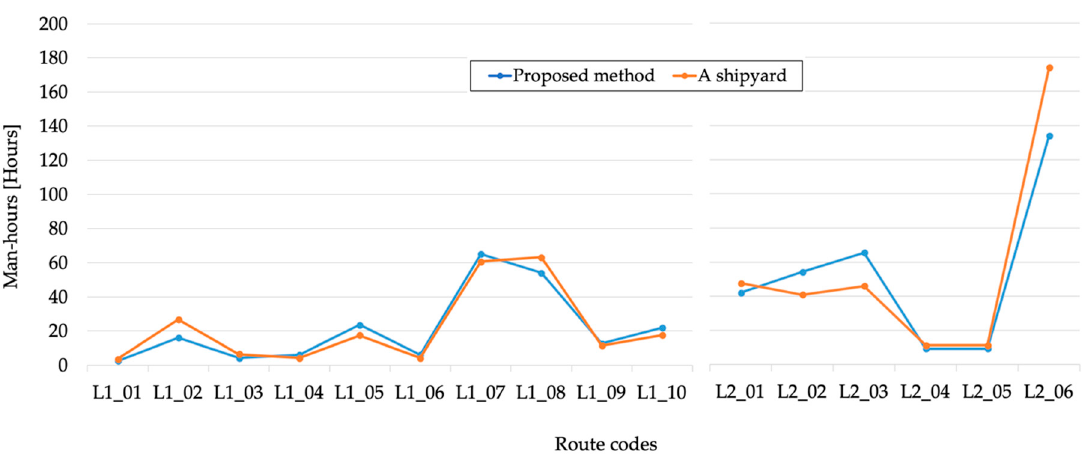
Figure 9. Comparison between production metrics obtained via the proposed method after applying the correction factor (blue) and shipyard data (orange): L1-level (left) and L2-level (right) blocks. Table 7. Comparison of production metrics before and after correction process.